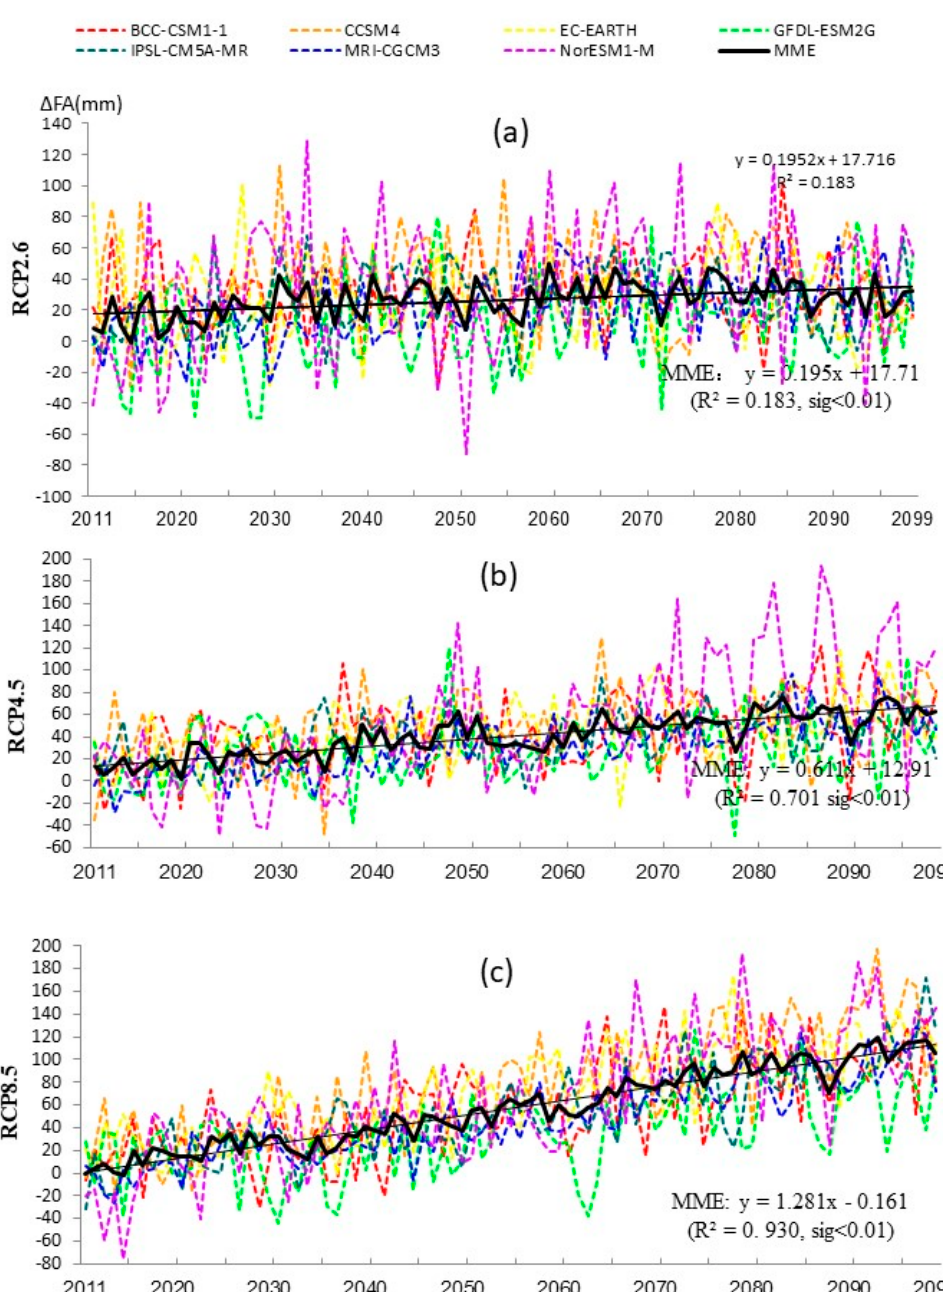
Figure 5. ∆ FA of China in the 21st century projected by CMIP5 models, ( a ): RCP2.6; ( b ): RCP4.5; ( c ): RCP8.5.